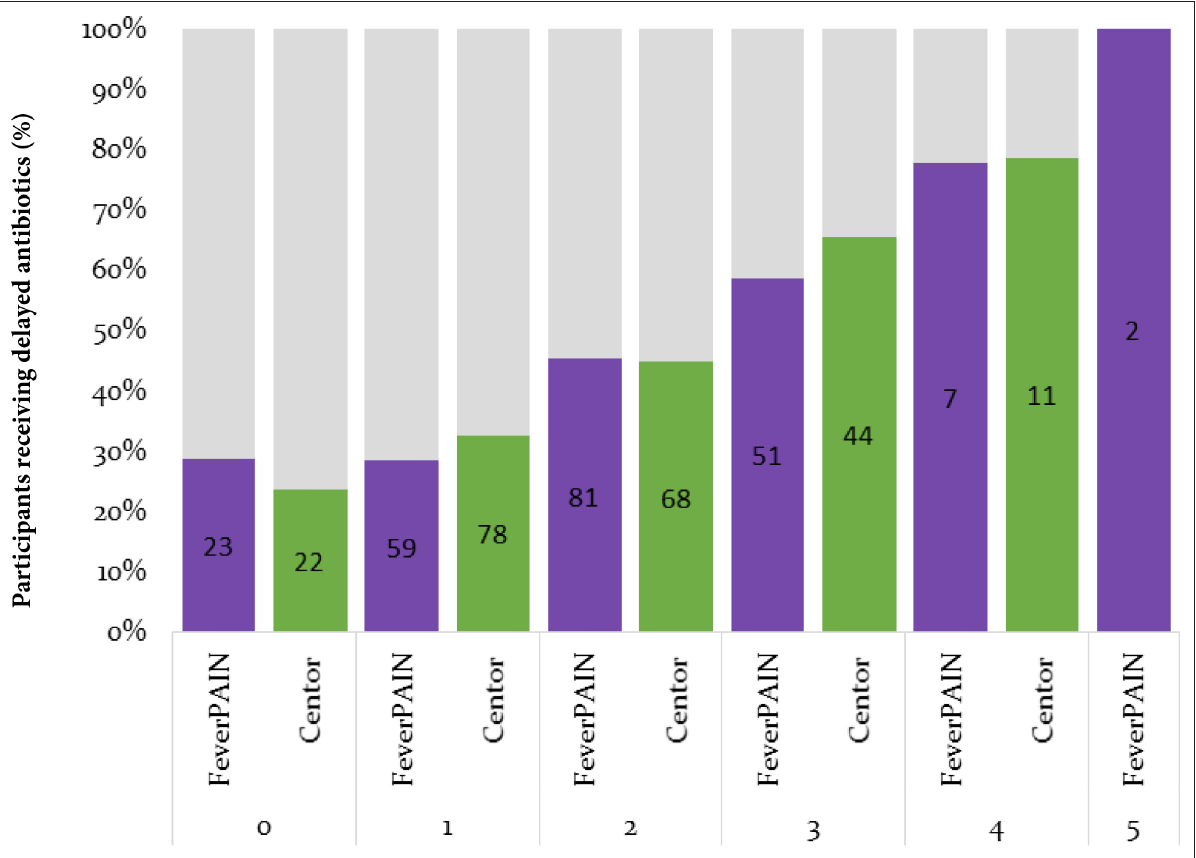
Figure 4 Delayed antibiotics prescribed in TOAST according to each clinical preduction rule score. The graph displays the percentage of participants in each clinical decision score who were prescribed delayed antibiotics at presentation. The numbers within each bar indicate the number of participants who received a delayed prescription at each